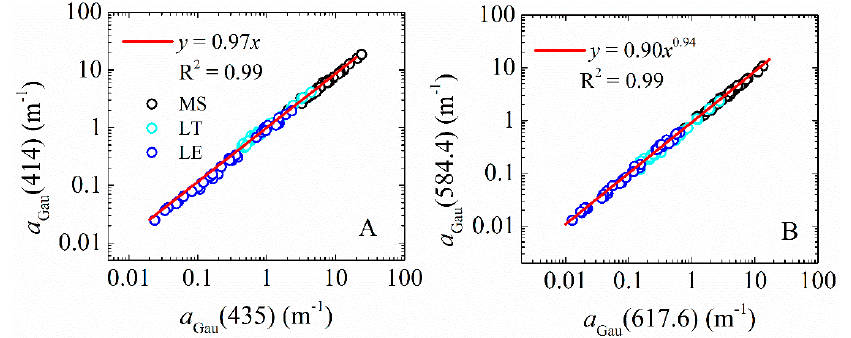
Figure 5. Example of empirical relationships among a Gau ( λ ) for three different datasets with MS in black, LT in light blue and LE in dark blue: ( A ) linear relationship between a Gau (414) and a Gau (435); and ( B ) power-law relationship between a Gau (584.4) and a Gau (617.6).